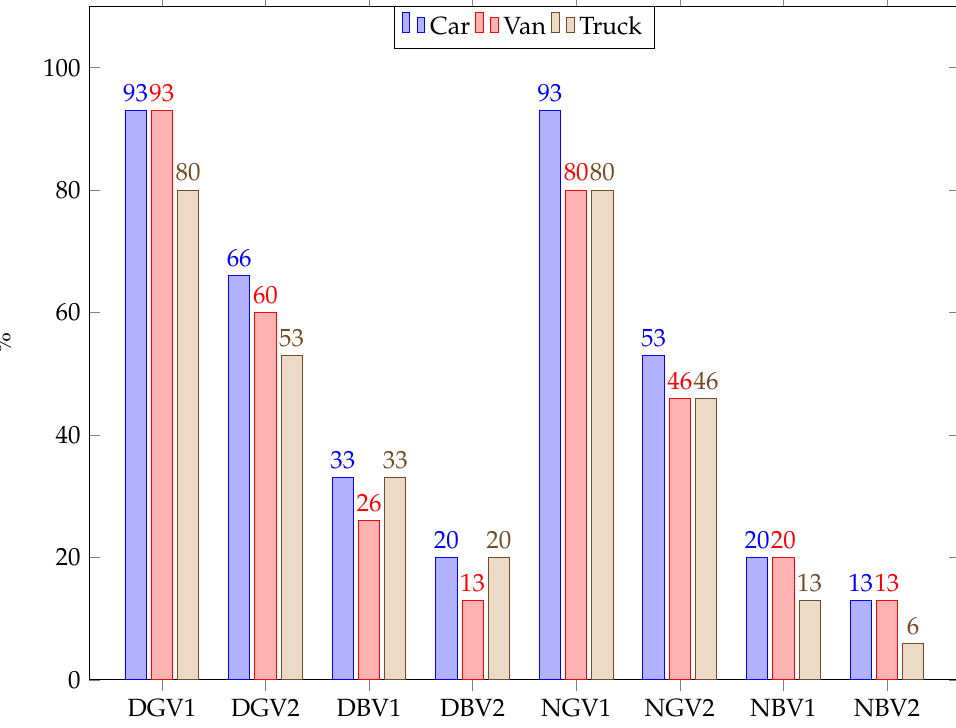
Figure 5. Comparison graph for evaluation results with and without user